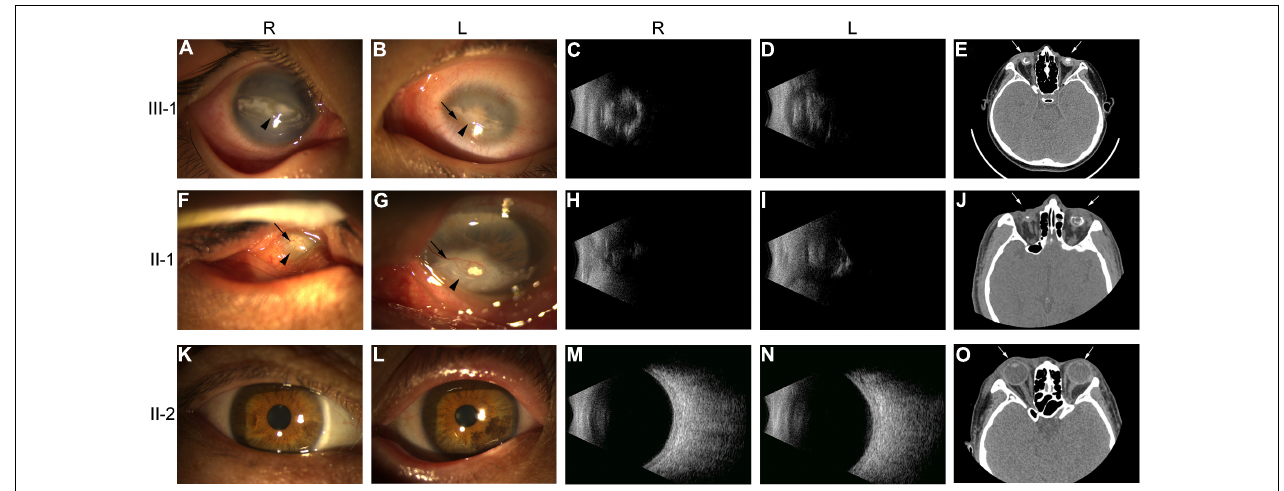
FIGURE 2 | Ophthalmologic examination of members III-1, II-1, and II-2 of the ND family. (A,B,F,G,K,L) Anterior segment photography of III-1, II-1, and II-2. Black arrows indicated neovascularization; arrowheads indicated keratoleukoma. (C,D,H,I,M,N) Vitreous supersonic inspection. (E,J,O) CT inspections of the ears and eyes. White arrows indicated eyes. R, right eye; L, left